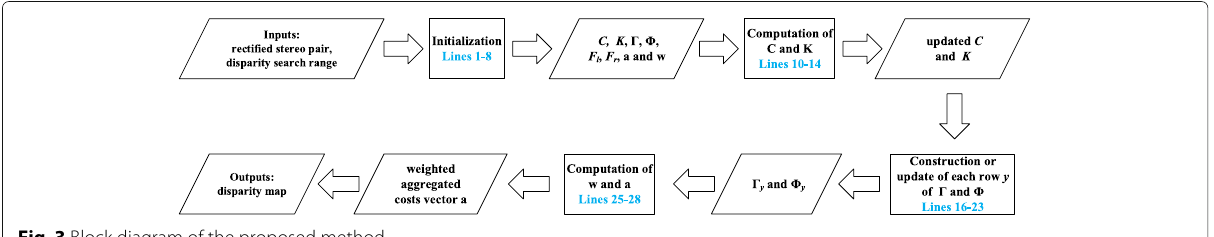
Fig. 3 Block diagram of the proposed